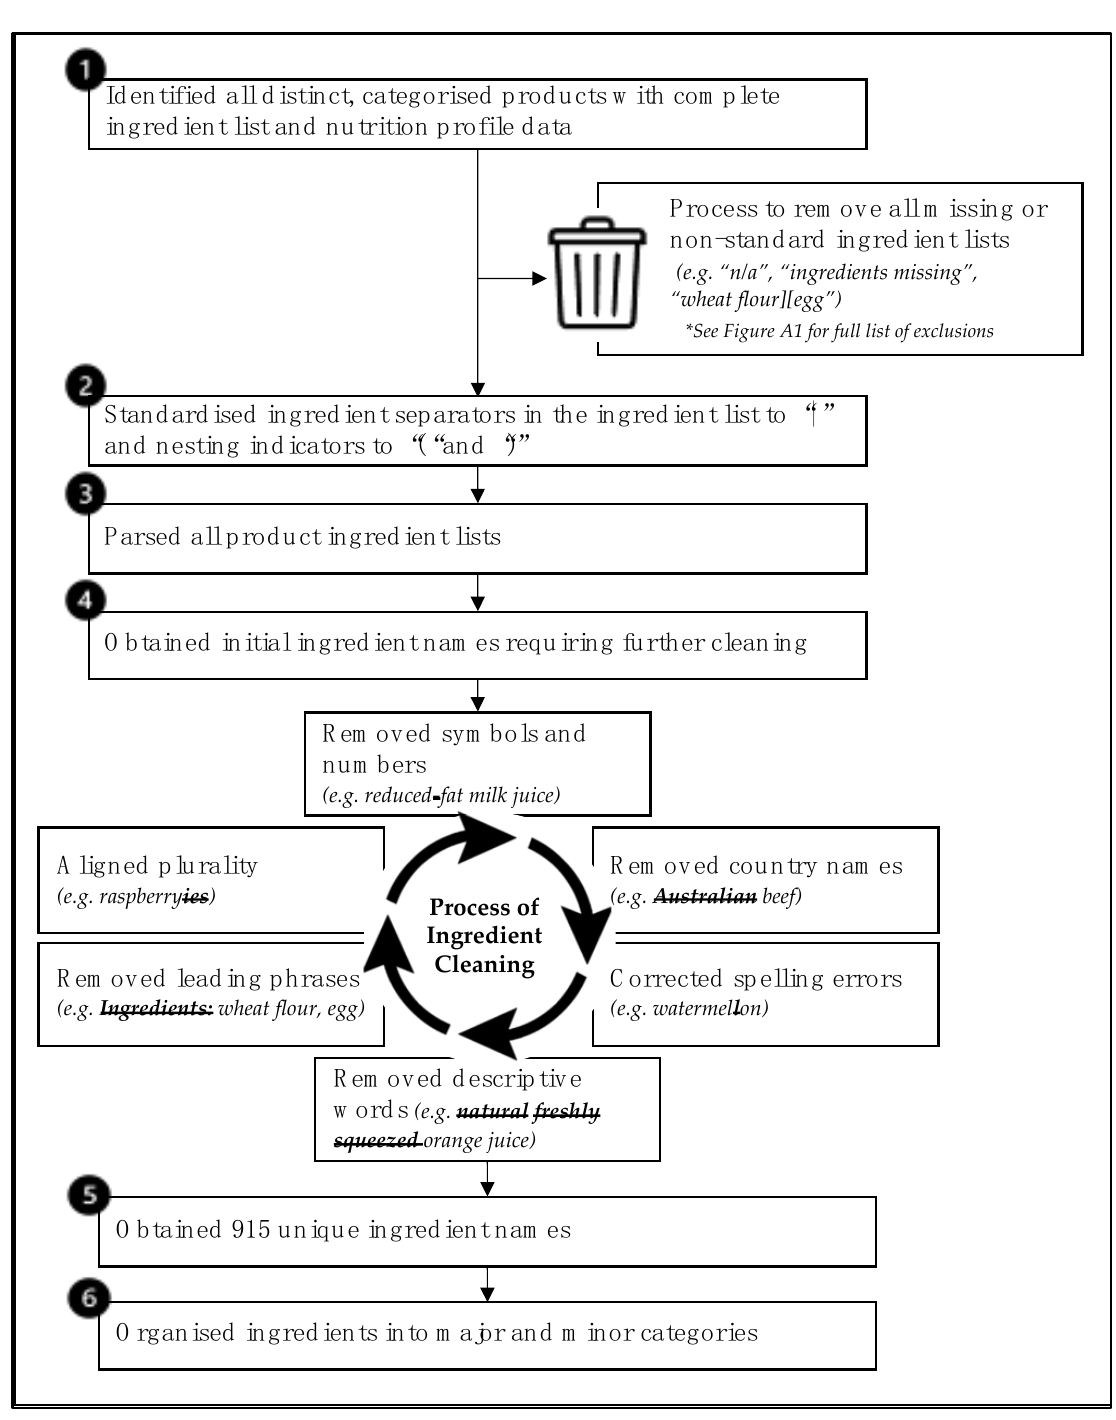
Figure A1. Workflow for developing the list of unique ingredients in Australian food and beverage products. Struck-through words and descriptors that were removed during the process of ingredient cleaning.